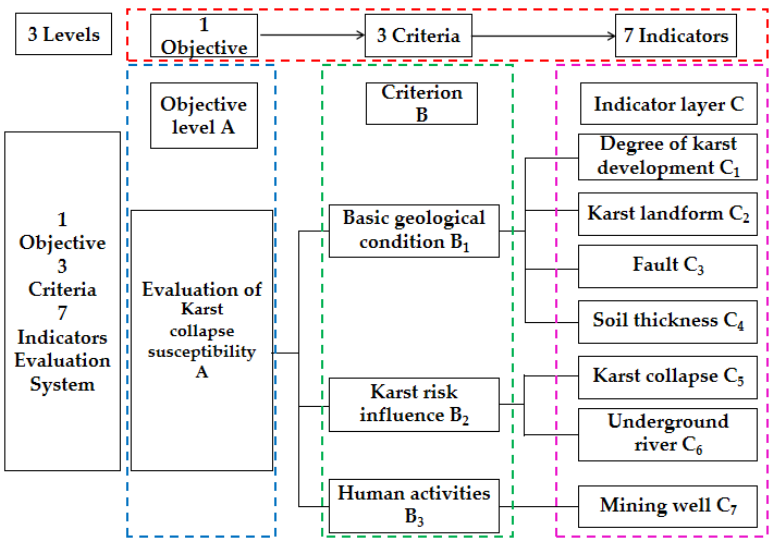
Figure 7. Evaluation system.